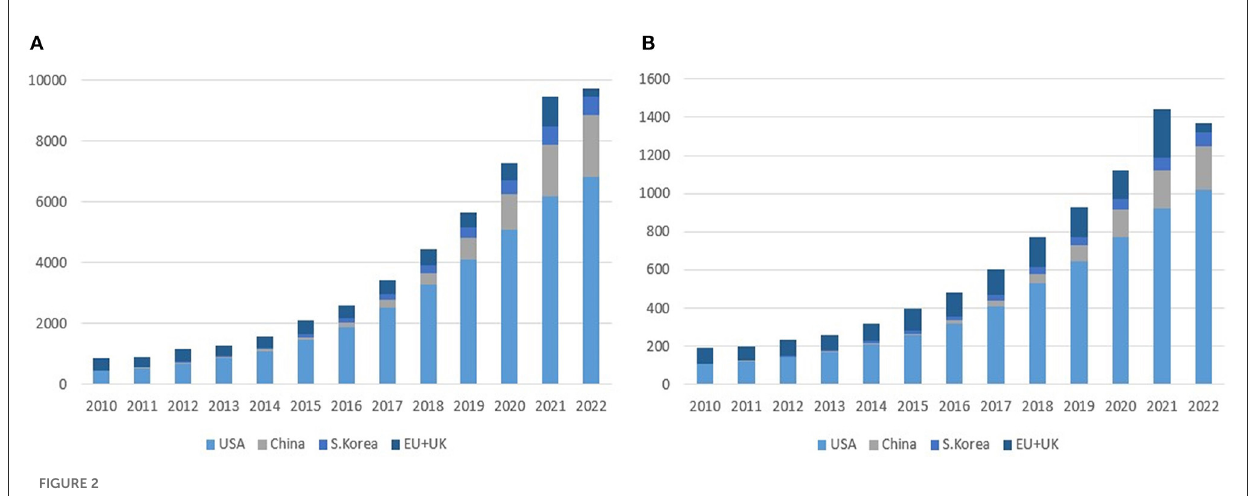
FIGURE2 Cell and gene therapy clinical trials by region (2010–2022). (A) Cell therapy. (B) Gene therapy. Source: NIH’s ClinicalTrials.gov, EU’s ClinicalTrialsRegister.eu (as of August 2022). The unit of the Y-axis is the number of clinical